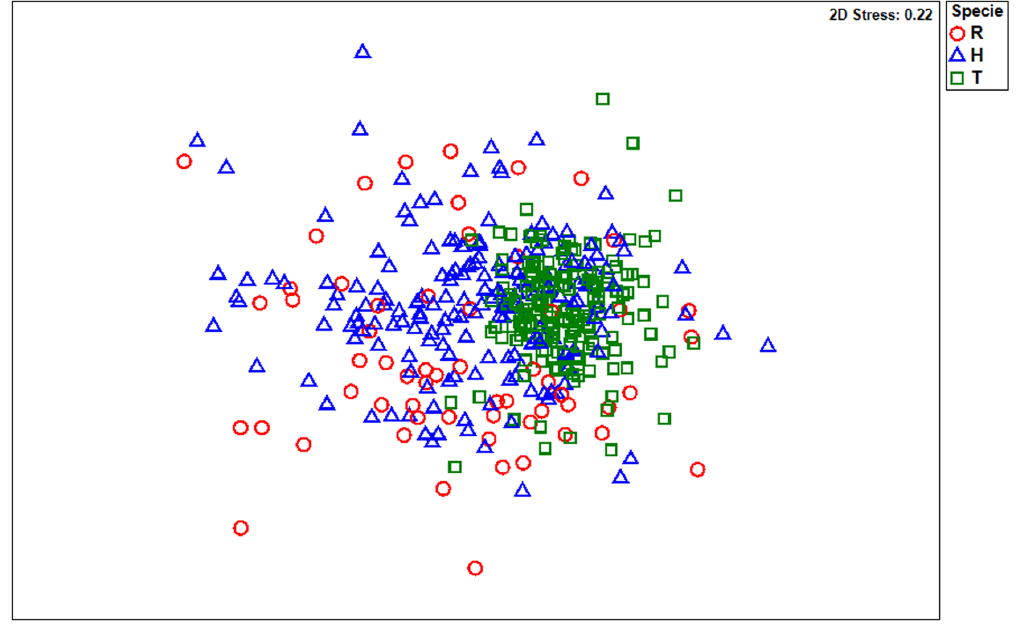
Figure 2. Two-dimensional plot of three fish species analyzed in Alto Jacuı´ sub-basin. The ordination resulting of the NMDS of the three species. For specie code see Table 1. doi:10.1371/journal.pone.0110999.g002 PLOS ONE |